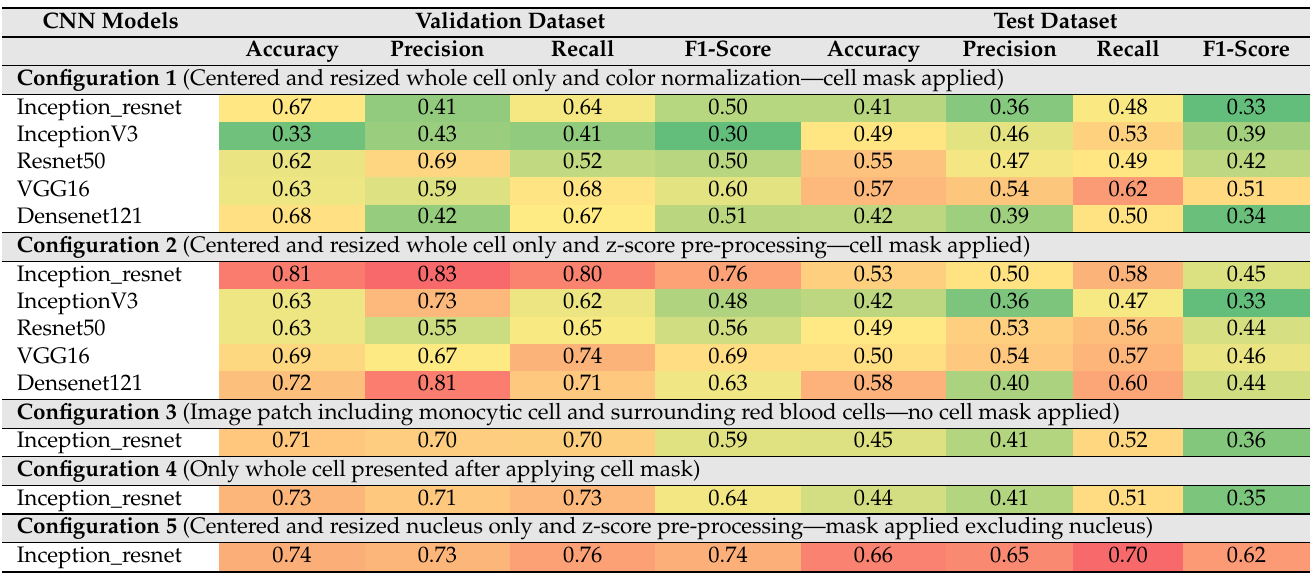
Table 1. Performance of CNN models using five pre-processing configurations on 3-subcategory (monocytes, promonocytes, and blasts) classification